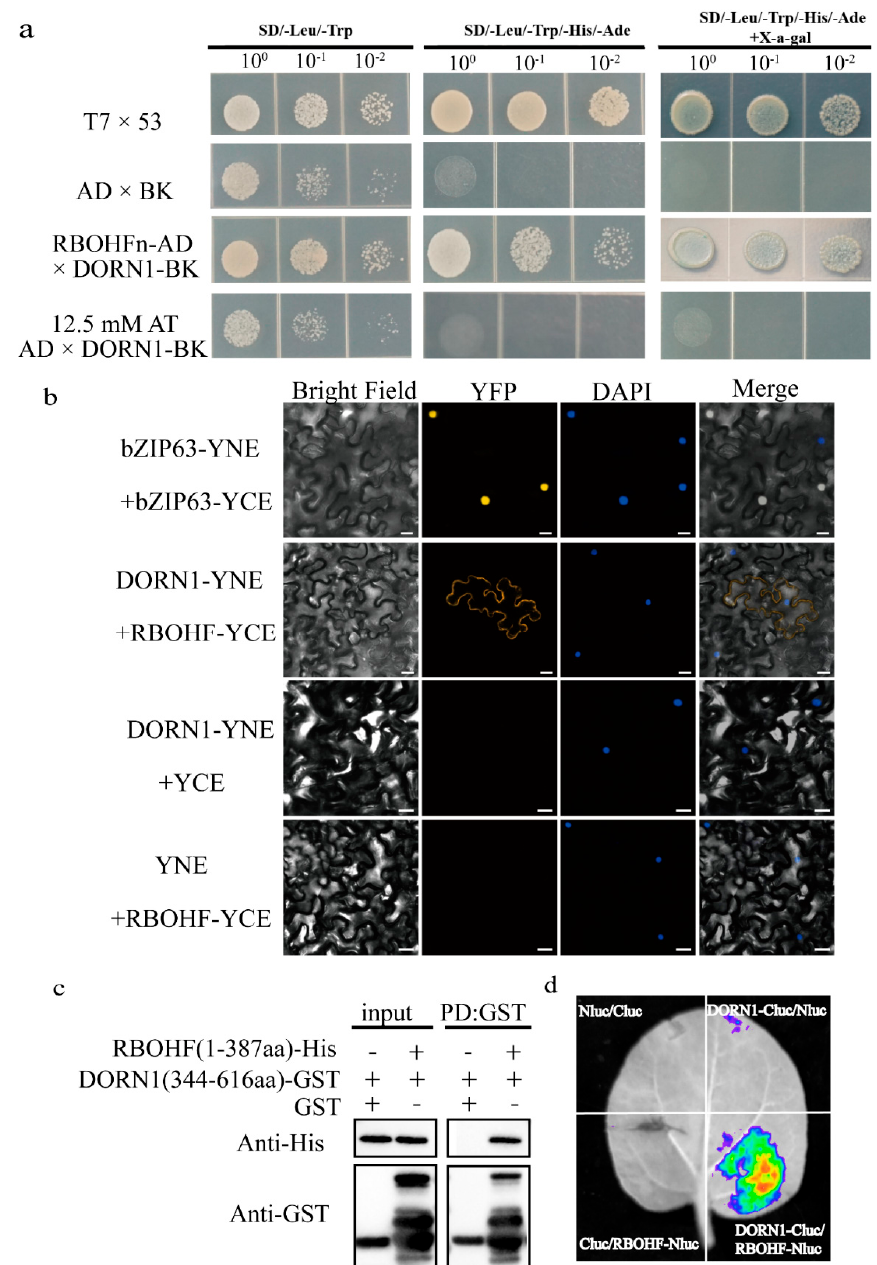
Figure 6. RBOHF interacts with DORN1. ( a – d ) Y2H, BiFC assay, LCI assays, and in vitro pulldown, respectively, show that RBOHF interacts with DORN1. ( a ) In the Y2H assays, the DORN1 was used as the bait vector. DORN1 has self–activation and can be inhibited by 12.5 mM 3 − AT. Yeast clones were grown on SD/ − Leu/ − Trp and SD/ − Ade/ − His/ − Leu/ − Trp and SD/ − Ade/ − His/ − Leu/ − Trp with X- α− gal plate. When the self − activation is inhibited, the colony grows well on these plates. ( b ) In BiFC assay confirms the interactions between RBOHF and DORN1 on the plasma membrane. DAPI (blue) was applied to mark the nucleus. Bar = 25 μ m. ( c ) GST–DORN1 can pull down the RBOHF with His tag, while GST − 4T − 1 cannot pull down the RBOHF. ( d ) In the LCI assay, only DORN1 − Cluc/RBOHF − Nluc zone has stronger fluorescence than the other three control parts: Cluc/Nluc, DORN1 − Cluc/Nluc, Cluc/RBOHF − Nluc.